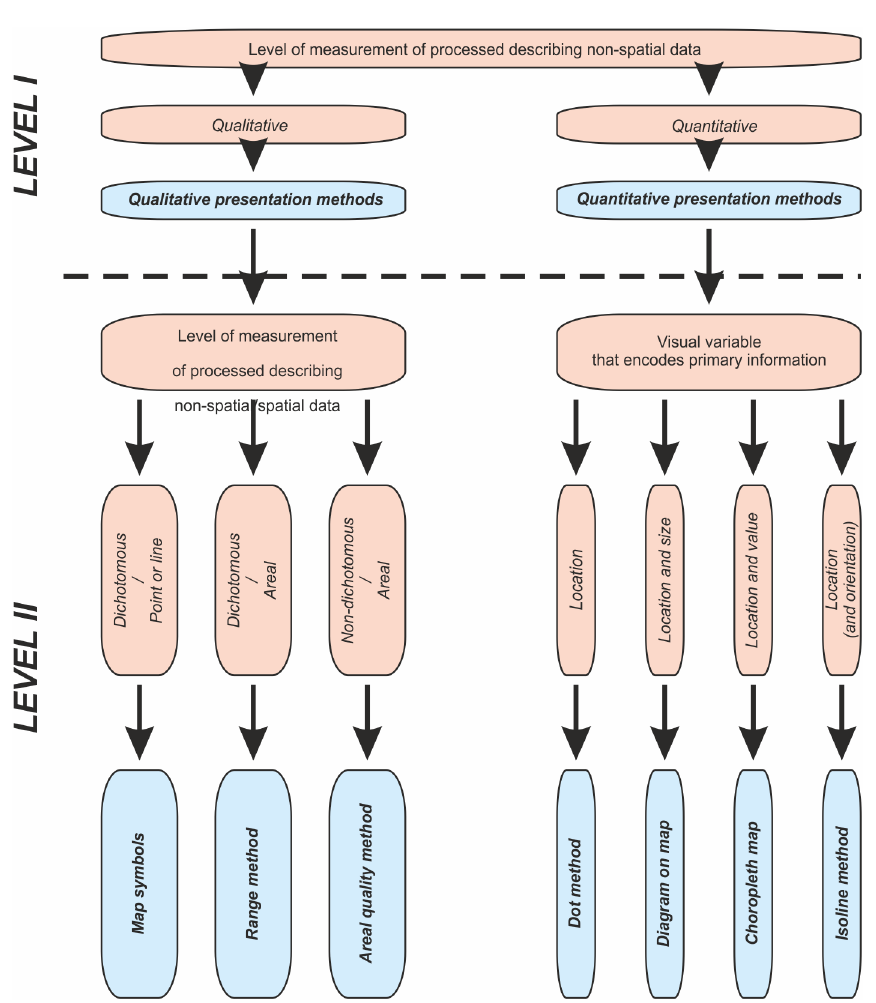
Fig. 2. The scheme of classification criteria and cartographic presentation methods differentiated using